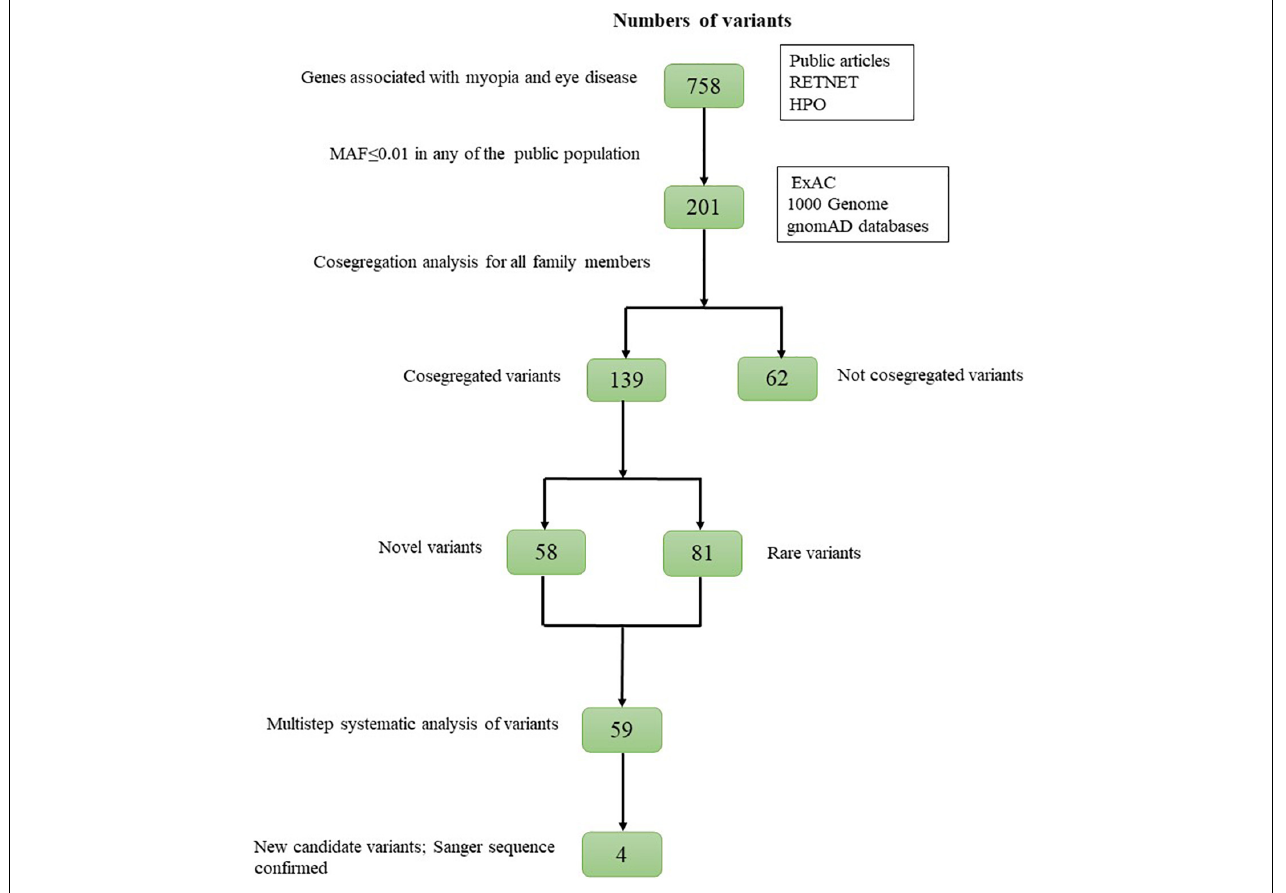
FIGURE 1 | Overview of the variant filtering